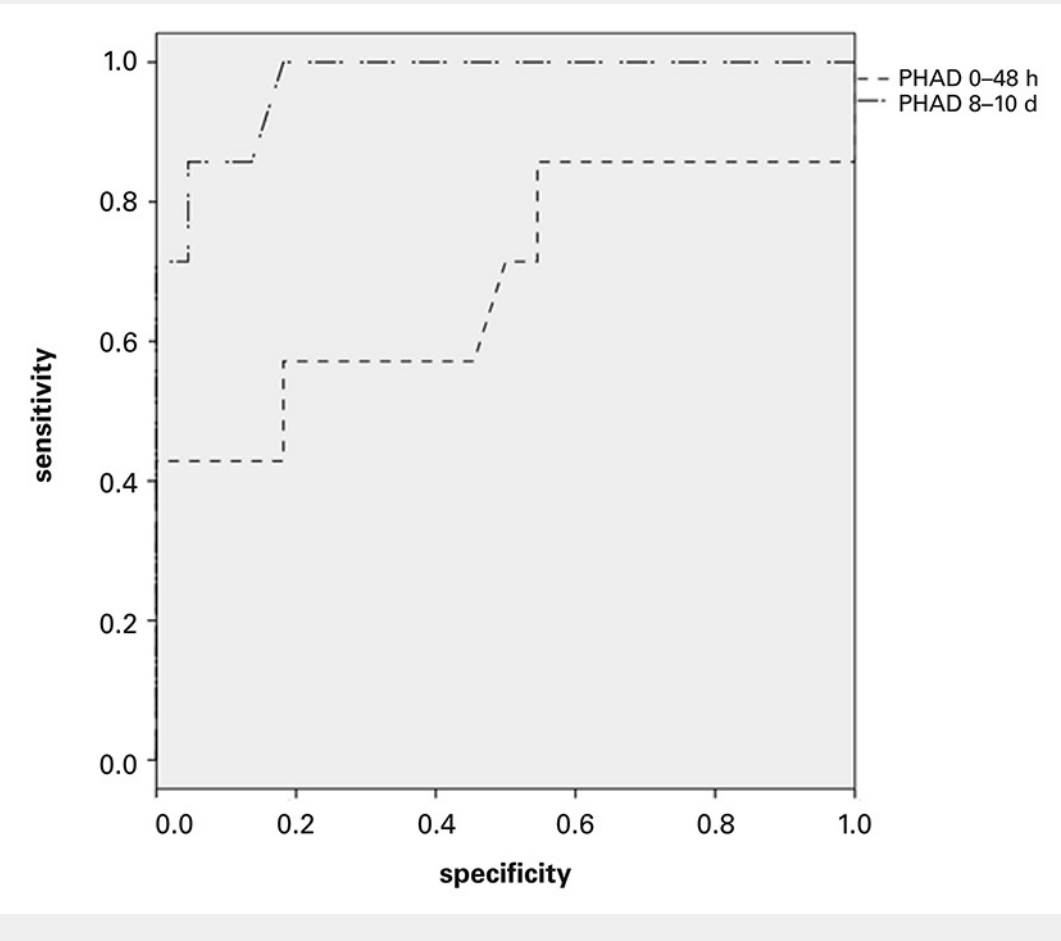
Figure 2 Receiver operator curve (ROC) -analysis of Parramatta Hospitals’ Assessment of Dysphagia (PHAD) for prediction of “prolonged impairment of deglutition”. At second assessment (mean 8.7 days, SD ± 1.4 post stroke), ROC analysis for PHAD score in relation to serious to severe impairment of oral intake defined as a Bogenhausen-dysphagia-score, part 2 (BODS-2) score of ≥4 at 5–7 weeks after the stroke. Area under the curve (AUC) 0.971, 95% confidence interval 0.915–1.0. ROC analysis for PHAD score assessed in the first week: AUC 0.685, 95% CI